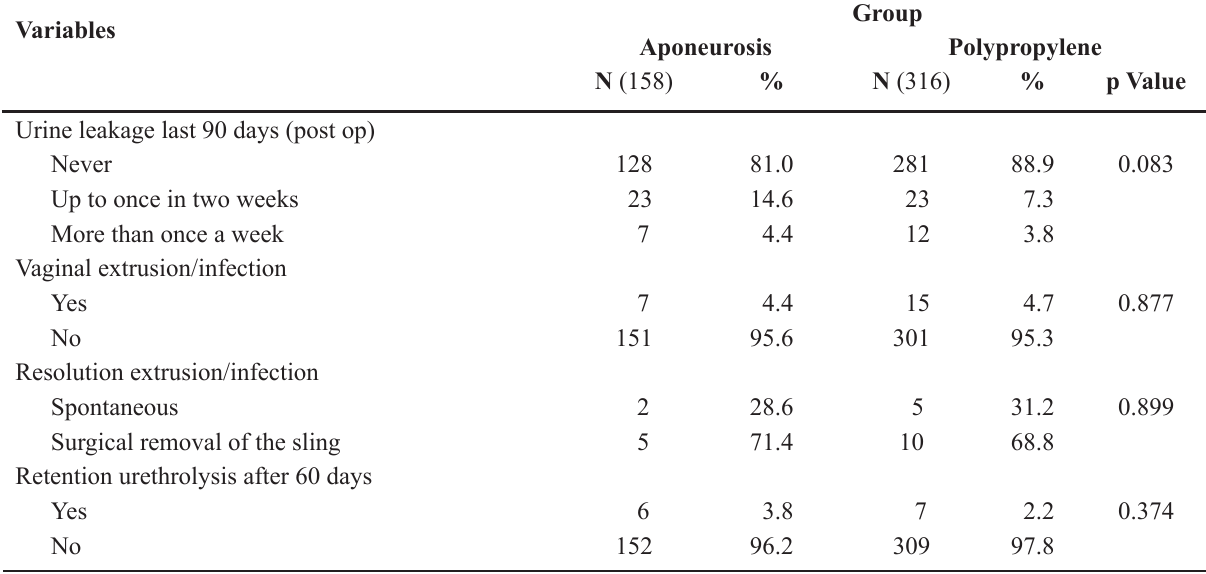
Table 2 – Number and frequency of urine leakage, vaginal extrusion/infection with resolution and retention/urethrolysis in women who underwent the surgical sling technique for SUI with aponeurosis or